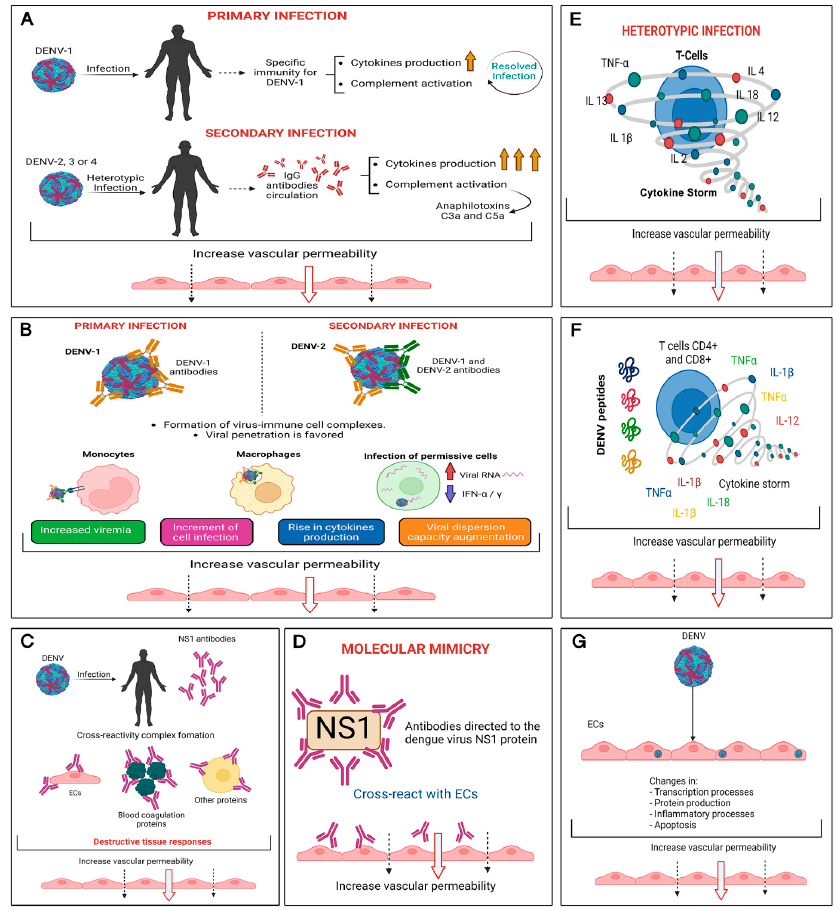
Figure 1. Molecular mechanisms associated with ED due to DENV. ( A ) Vascular permeability mediated by antigen (virus) + antibody (anti-virus) + complement proteins: in secondary heterotypic infection, the circulation of DENV-specific IgG antibodies activates the production of anaphylatoxins C3a and C5a of the complement system that mediate vascular permeability. ( B ) Antibody-mediated potentiation of the infection: in a secondary heterotypic infection (SHI), the antibodies from primary infection recognize and form complexes with the DENV serotype involved the secondary infection (reinfection). These complexes bind to monocytes and macrophages through Fc receptors that favors the viral entry, increasing the number of infected cells, viremia, and the cell-to-cell viral spread capacity that affects endothelial permeability. In addition, direct infection of permissive cells causes an intrinsic antibody-dependent enhancement (iADE) where viral replication and the consecutive production of viral RNA generate a downregulation on interferon alpha and gamma (IFN α / γ ), and an upregulation of different cytokines that can be directly related to endothelial damage. ( C , D ) Heterophilic immunity and molecular mimicry: during DENV infection, antibodies directed against the NS1 protein are generated; these antibodies have cross-reactivity with ECs, blood coagulation proteins, and other cells such as hepatocytes. These antibodies, considered as mimetics, reach a pathogenic potential during a SHI, generating destructive responses in the endothelium. ( E ) Exaggerated T cell response: during SHI, different memory T cells release exaggerated amounts of cytokines that affect vascular permeability. ( F ) T cell response, guided by antigenic sin (tendency of immune system to preferentially use immune memory based on a previous infection when a second, slightly different version of this foreign entity is encountered): different variants of DENV peptides induce the production of different sets of cytokines. The response of T cells influenced by antigenic sin causes the uncontrolled cytokine production (cytokine storm), which increases vascular permeability. ( G ) Direct infection of ECs: DENV can directly infect ECs, triggering processes such as apoptosis and generating products that increase vascular permeability